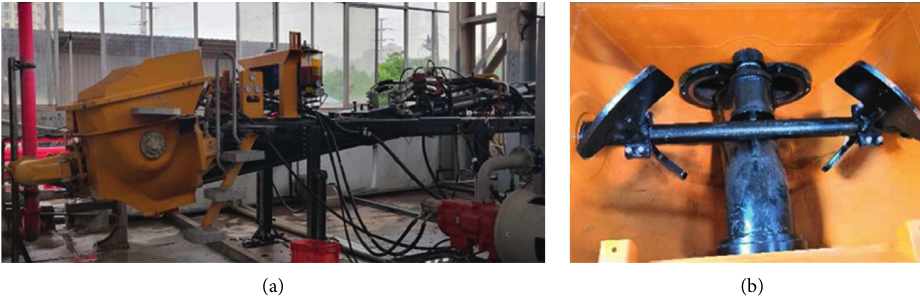
Figure 7: Pumping suction test device (a) and the internal situation of the hopper (b).